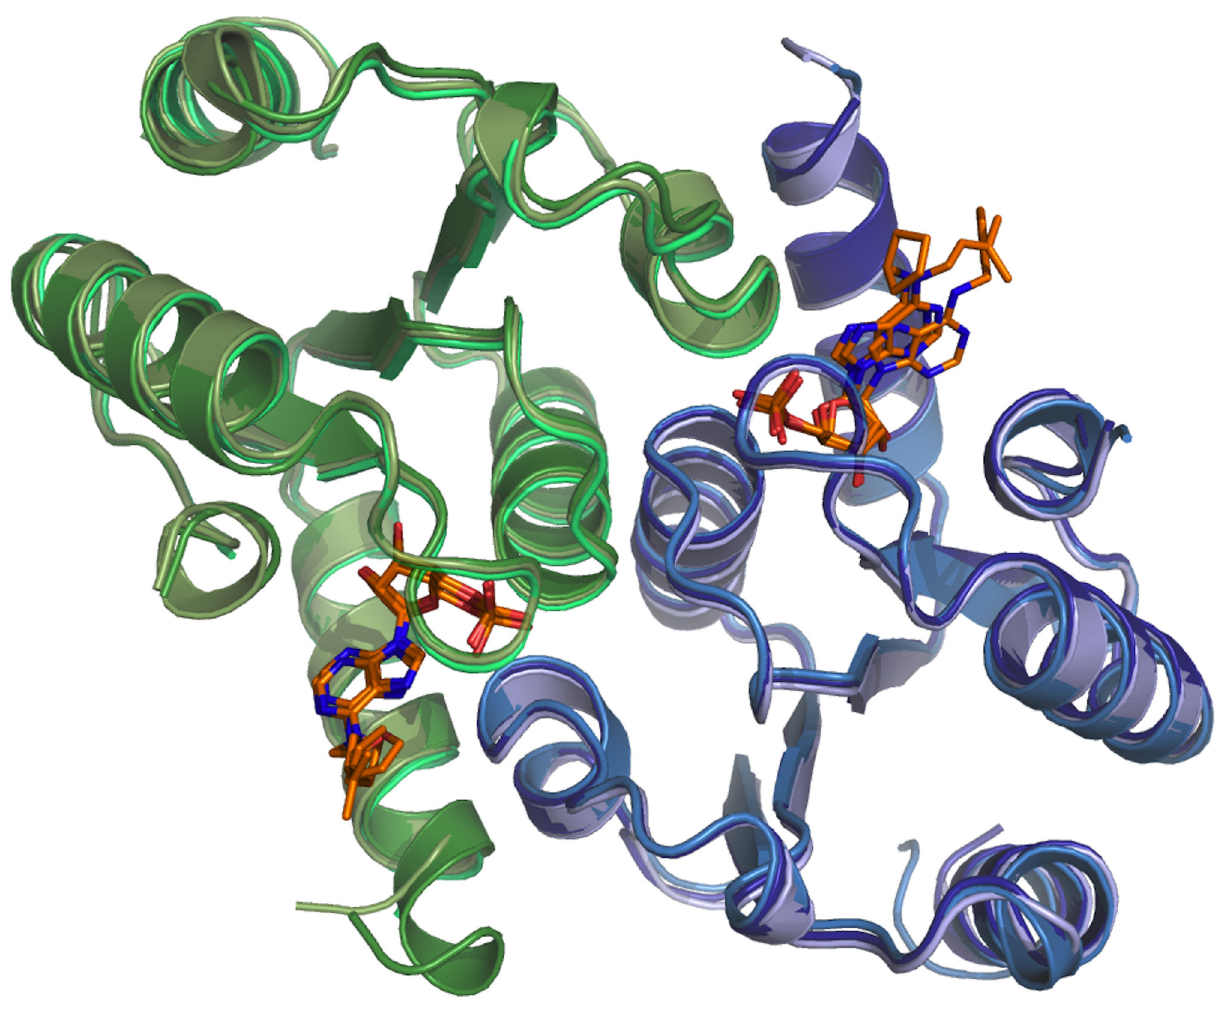
Figure 5. Superposed crystal structure of rat DNPH1 in complex with nucleotides N 6 -cyclopentyl AMP, N 6 -furfuryl AMP and N 6 -isopentenyl AMP (compounds numbered 7, 5 and 1 in the text, respectively). One dimer of each complex is shown in blue/ green ribbons. The corresponding ligands are shown as orange sticks. The figures were generated by Pymol (www.pymol.org).